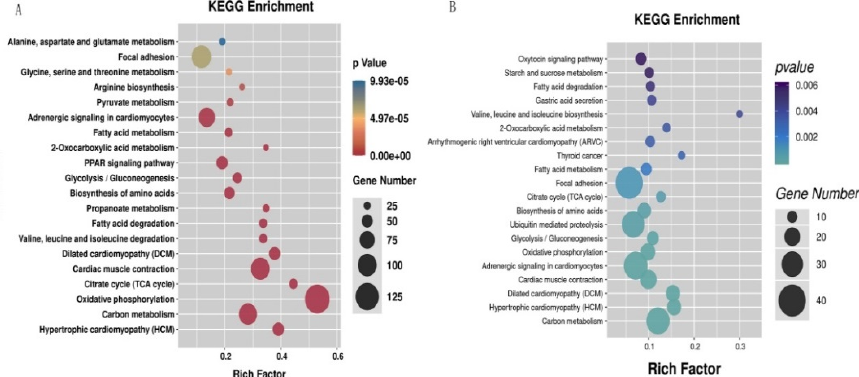
Figure 3. The top 20 significantly enriched pathways in KEGG enrichment of the differential ex- pression genes (DEGs) ( A ) and the differential expression target genes (DETGs) ( B ).